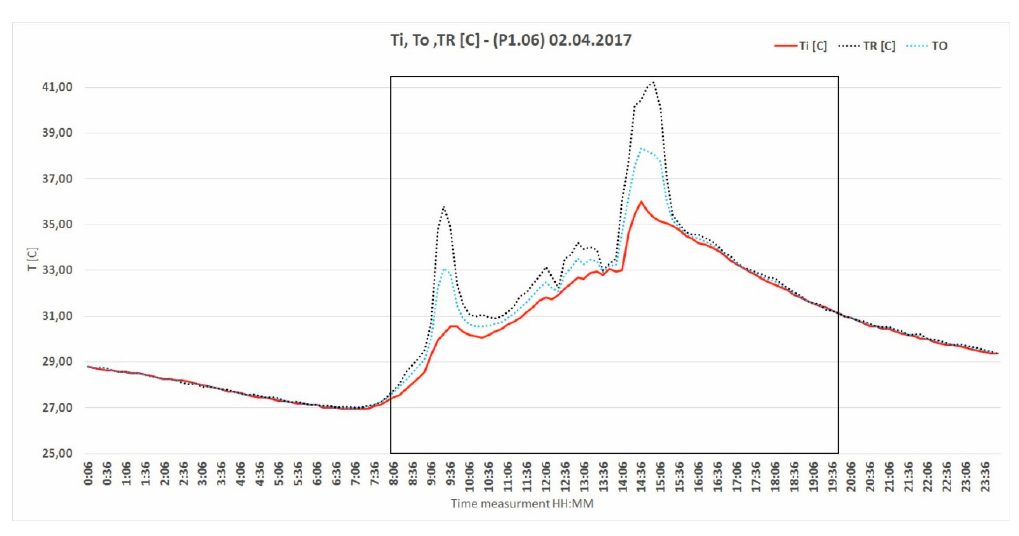
Figure 10. Values of ambient air temperature T i , mean temperature of a blackened sphere TR and resultant operating temperature T o (Room P1.06) on 2 April 2017.